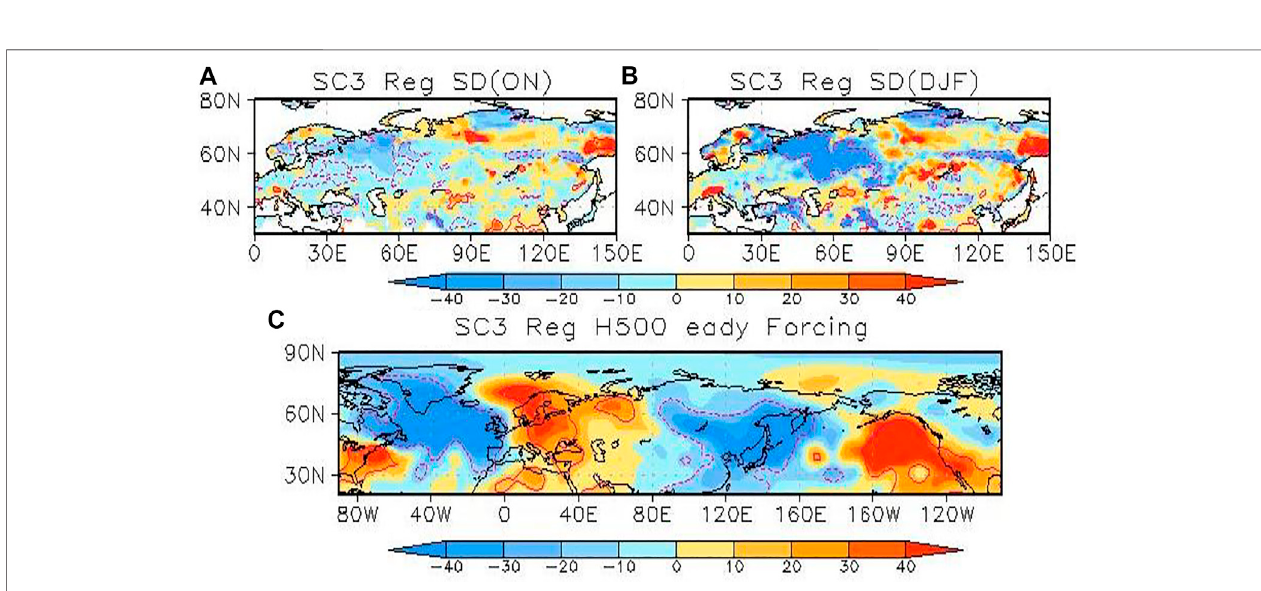
FIGURE 9 | Regressed anomalies of ON (A) , (B) DJF snow depth (shading, units: mm), and (C) H500 synoptic eddy-vorticity forcing onto expansion coef fi cient time series of snow cover in the third SVD mode. The red line indicates the value signi fi cantly exceeding the 90% con fi dence level.